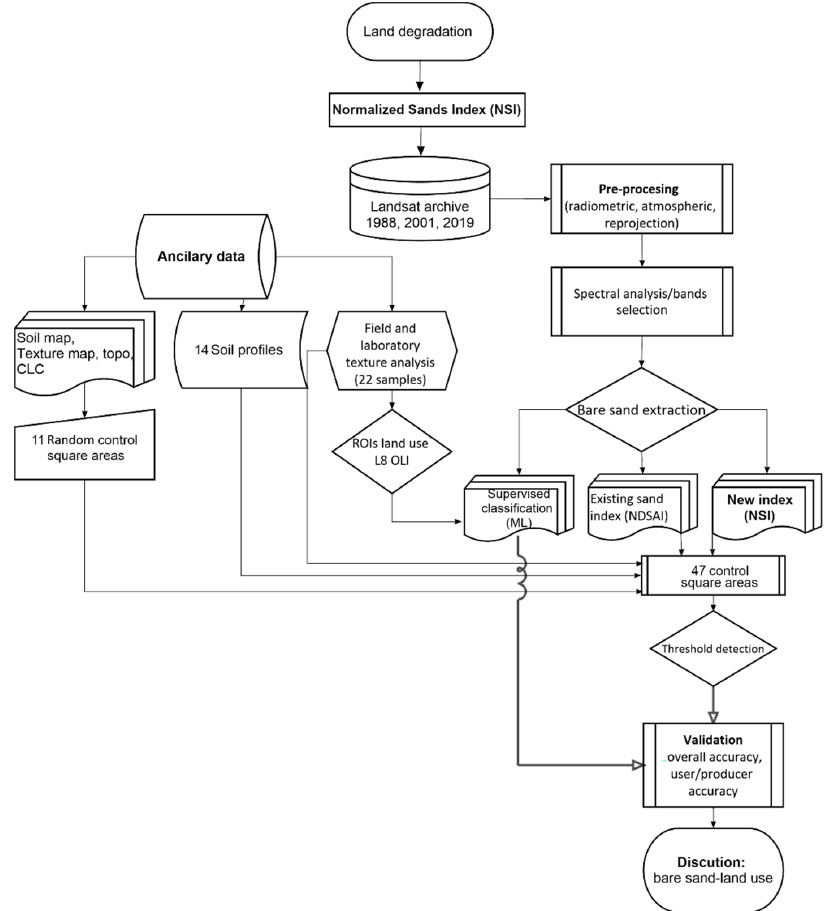
Figure 3. Methodological flowchart.